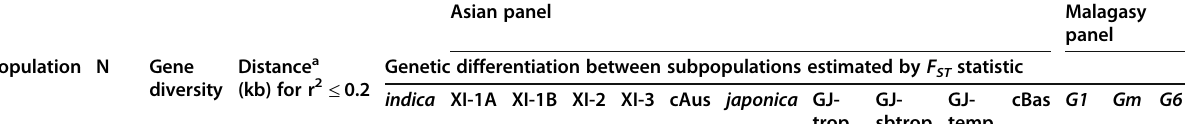
Table 1 Gene diversity, linkage disequilibrium and genetic differentiation between populations estimated by F ST statistic Asian panel Malagasy Population